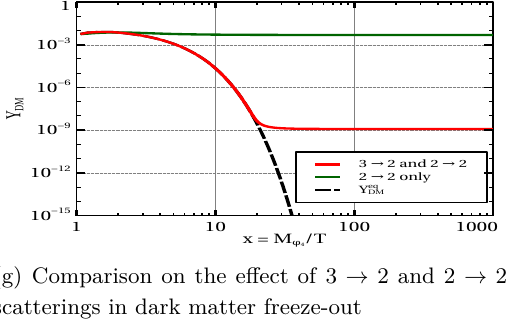
Figure 6 . Numerical results: evolution of Y DM with x for various model parameters like ξ , θ D , , M , M and g M φ φ 4 Z µτ µτ 2